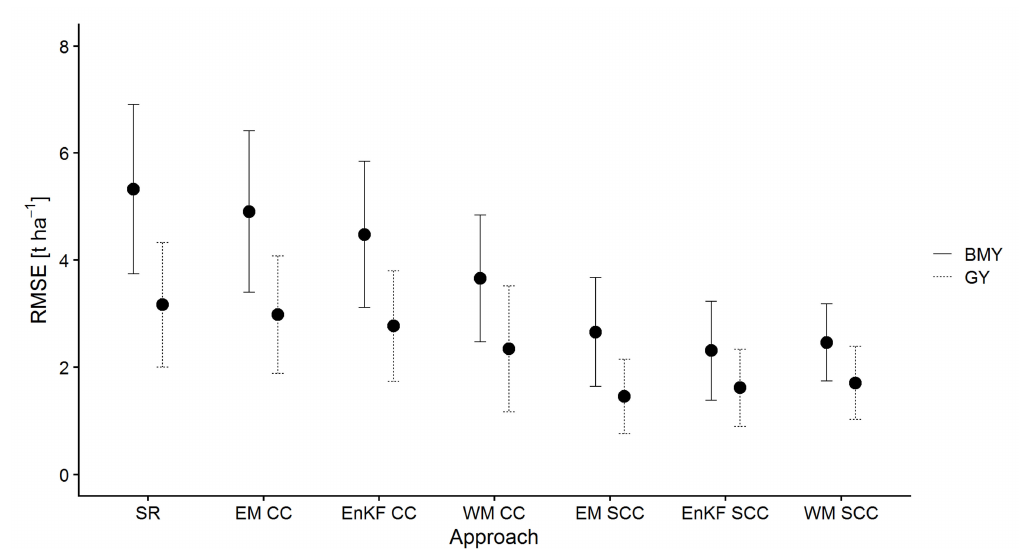
Figure 2. Mean and standard deviation of RMSE of total aboveground biomass yields (BMY—solid line) and grain yields (GY—dashed line) of 14 sites per approach. SR: Standard Run, EnKF: Ensemble Kalman Filter, WM: Weighted Mean, EM: Ensemble Mean, CC: Crop Component Set, SCC: Soil and Crop Component Set. All values in t ha − 1 . Table 4 lists the per-site RMSE results of simulated vs. measured grain yields at harvest. In 10 sites, the highest RMSE was produced by SR (Sites 1, 2, 4, 6, 7, 8, 9, 12, 13, 14), in two sites by WM CC (Sites 3 and 11), and in two sites by EnKF SCC and EM SCC, respectively (Sites 10 and 5). The lowest RMSE was produced in 10 sites by either EnKF SCC or EM SCC. The lowest average RMSE of the 14 − 1 − 1 − 1 sites were produced by EM SCC (1.45 t ha ), EnKF SCC (1.62 t ha ) and WM SCC (1.70 t ha ), with